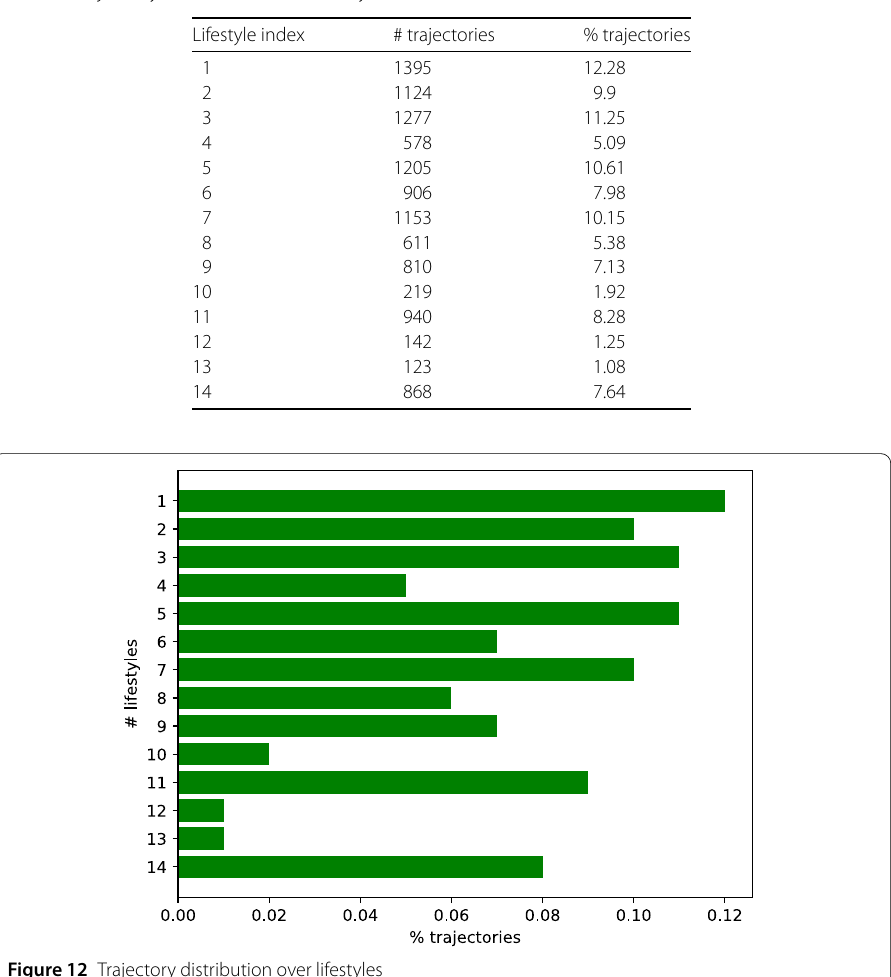
Table 3 Trajectory distribution over lifestyles